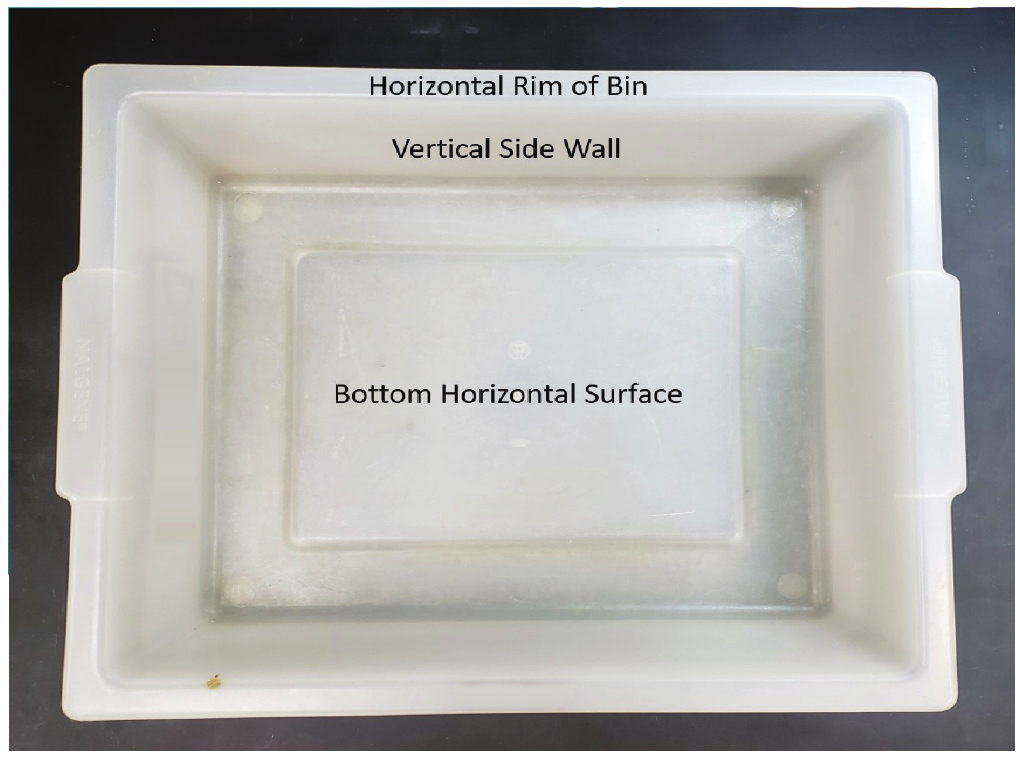
Figure 1 . Pictures of the bin used for testing and areas where the test organisms were